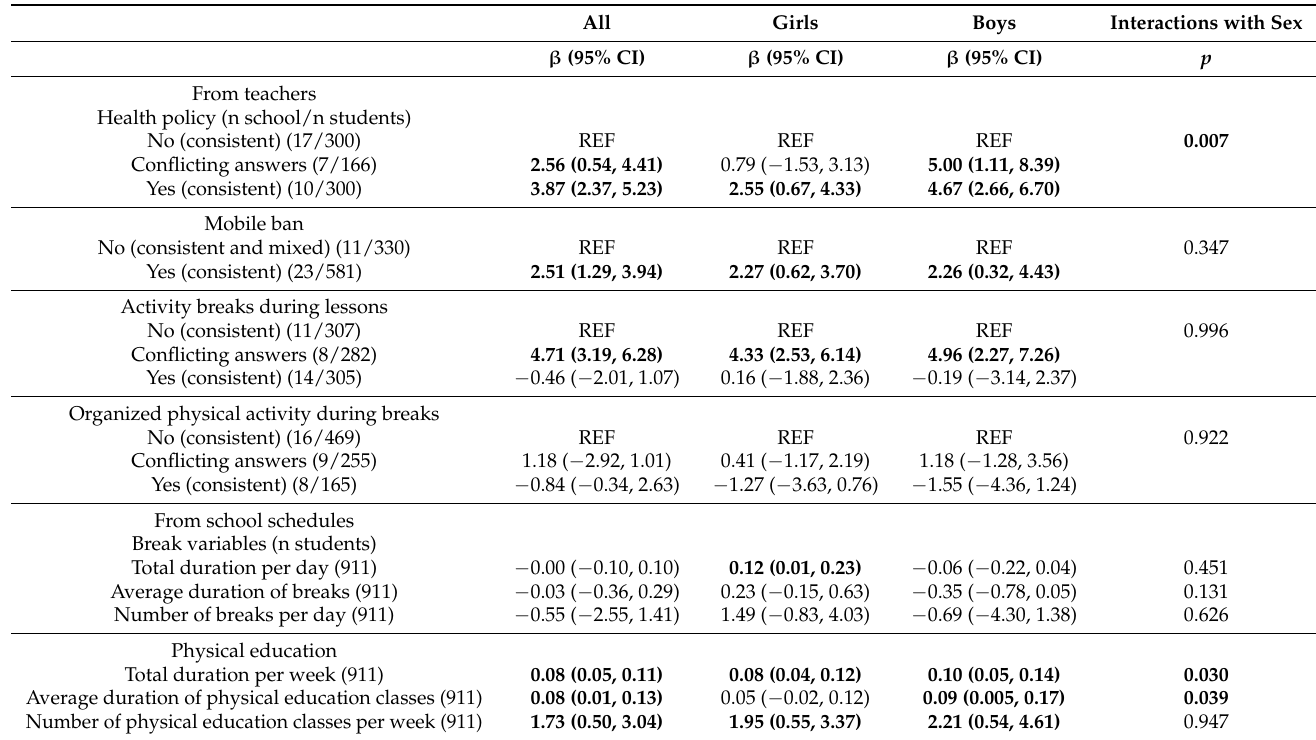
Table 2. Associations between the school environment and the participants’ moderate-to-vigorous physical activity (MVPA) in minutes during school